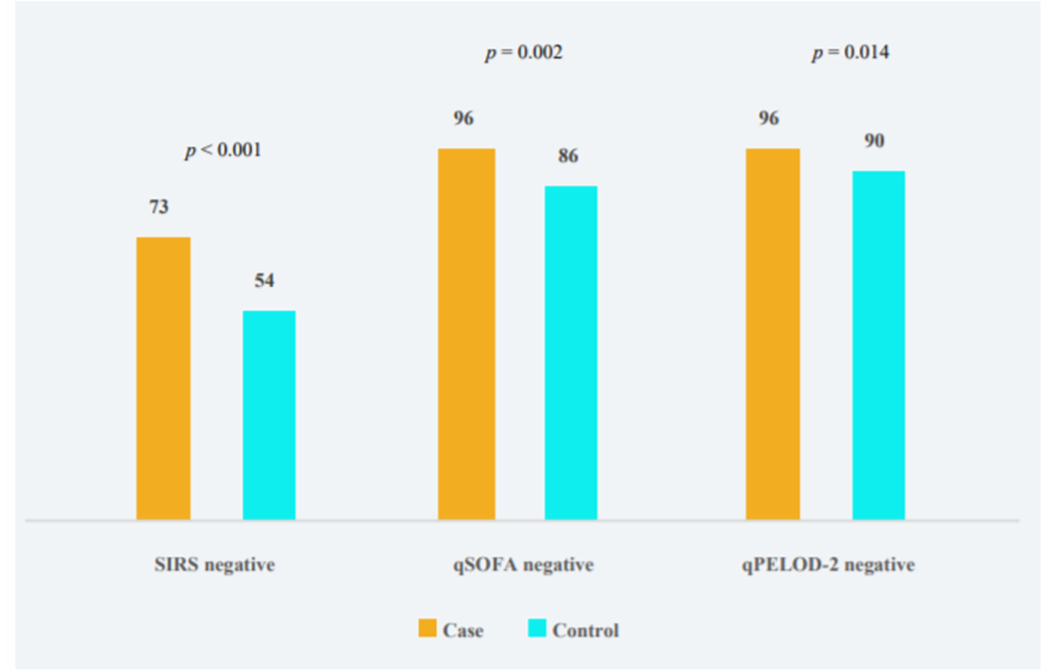
Figure 1. Distribution of included children without and with antibiotic therapy according to the percentage of negative (<2 scores) SIRS, qSOFA and qPELOD-2 criteria met.